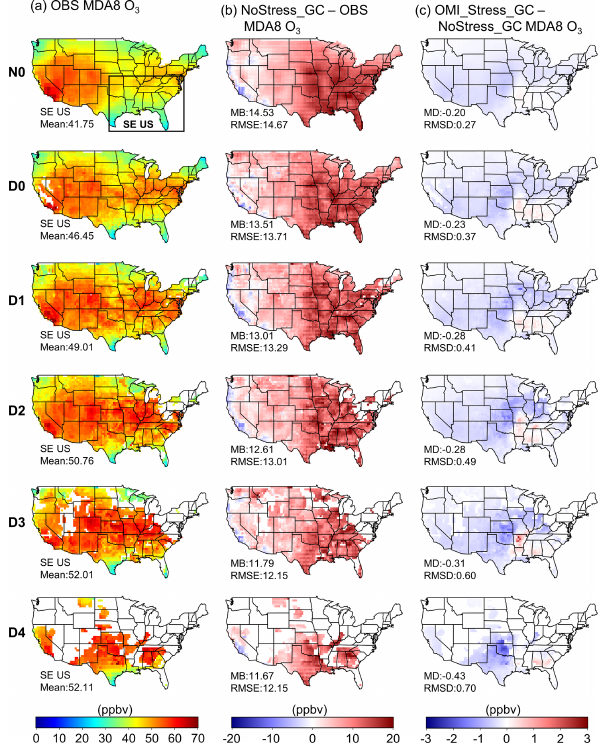
Figure 10. Mean HCHO column densities during JJA 2005–2017 by USDM dryness category for OMI (a) , NoStress_GC minus OMI (b) , and OMI_Stress_GC minus NoStress_GC (c) . Numbers in the bottom left-hand corner of panel (a) indicate the SE US (black box) regional mean of OMI HCHO column; numbers in the bot- tom left-hand corner of panel (b) indicate the mean bias (MB) and root-mean-square error (RMSE) in HCHO column densities between NoStress_GC and OMI; and numbers in the bottom left- hand corner of panel (c) indicate the mean difference (MD) and root-mean-square deviation (RMSD) between OMI_Stress_GC and NoStress_GC. The MD and RMSD are calculated in the same way as the MB and RMSE; however, the different names are used to dis- tinguish between model–model comparison and model–observation comparison, respectively.